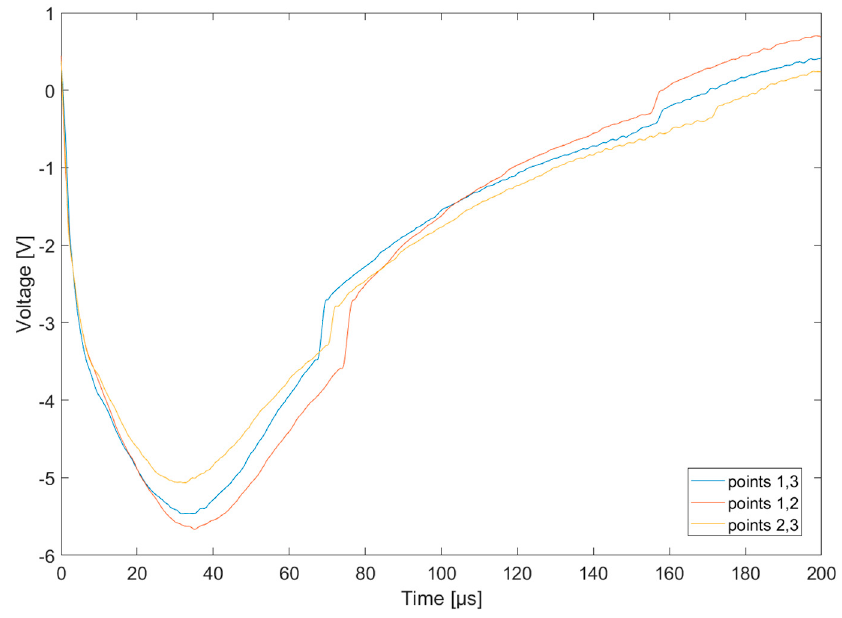
Figure 4. Input impulse (surge) on all motor coils—the same points to inject and measure.